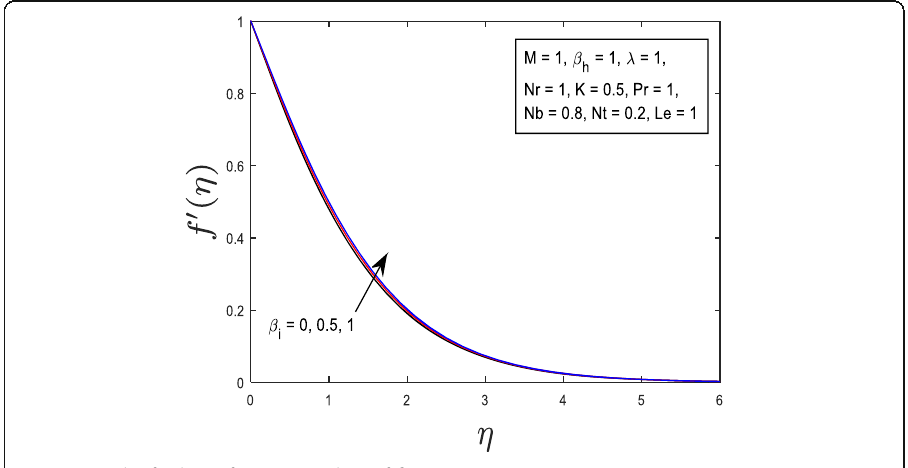
Fig. 10 Graph of velocity for various values of β